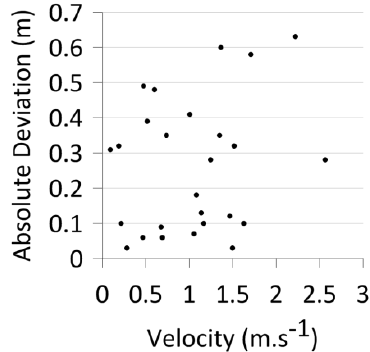
Figure 8. Plot describing the relationships between the flow velocity and absolute deviation of the PSI for Q optimum scenario. for Q optimum